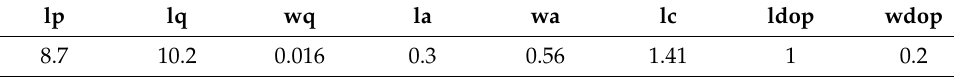
Figure 10. A top view of the circular to linear polarization switchable antenna design. Table 2. Dimensions (in mm) of the two circular to linear polarization reconfigurable antennae.